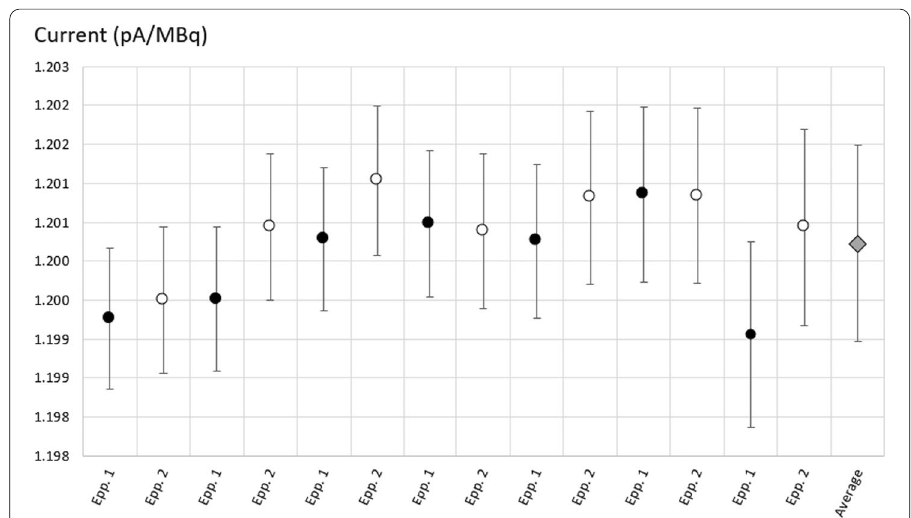
Fig. 10 Normalized current values for two Eppendorf tubes filled with 161 Tb. Each point represents seven measurements of both Eppendorf tubes performed at regular intervals over a period of 2 weeks